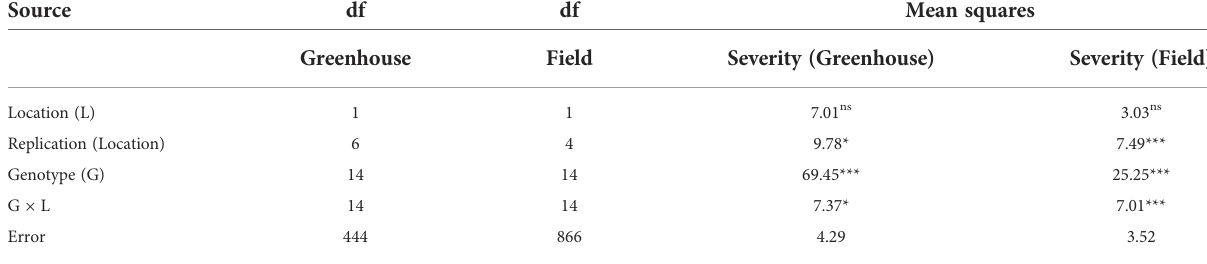
TABLE 1 Combined analysis of variance for ashy stem blight [caused by Macrophomina phaseolina (Tassi) Goidanich] severity for 15 common bean ( Phaseolus vulgaris L.) genotypes evaluated in the greenhouse and the fi eld in Isabela and Lajas, Puerto Rico, in